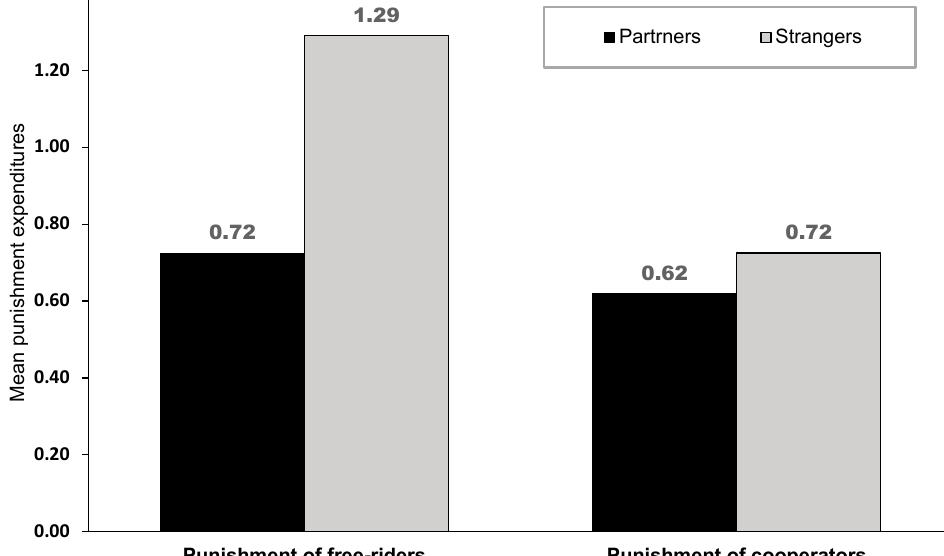
Figure 3. Mean expenditures on punishing free riders and cooperators.